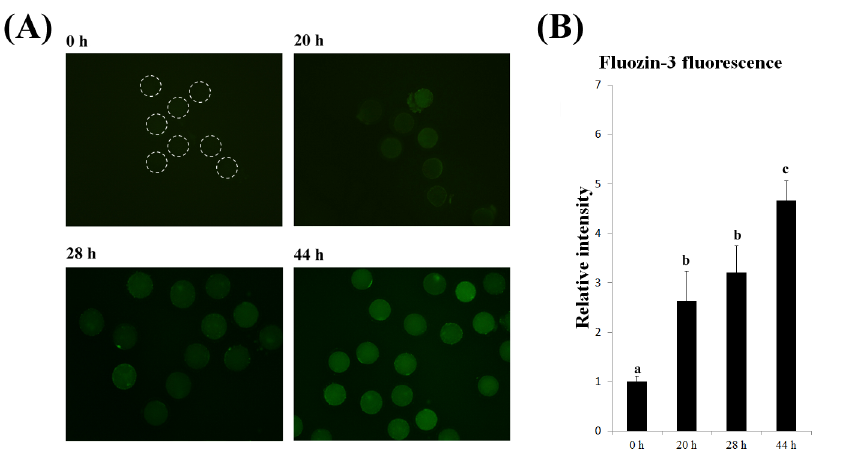
Figure 1. The level of free cytoplasmic zinc in oocytes increases during maturation. (A) Representative images of oocytes after 0, 20, 28, and 44 h of IVM. ( B ) The fluorescence intensity of fluozin-3-AM relative to that in oocytes after 0 h of IVM (set at 1) was analyzed using Photoshop. Data are expressed as mean values 6 standard error of the mean (SEM) of three independent experiments. White lines indicate the peripheries of oocytes. Different letters above the bars denote statistically significant differences (P , 0.05).